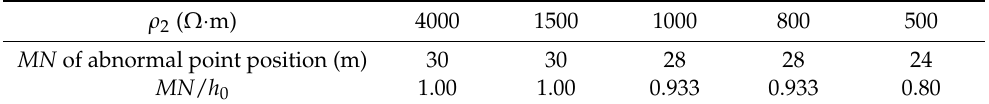
Table 3. Ratios of MN / h 0 at abnormal points of FSM sounding curve with different resistivity ρ 2 of surrounding rock.